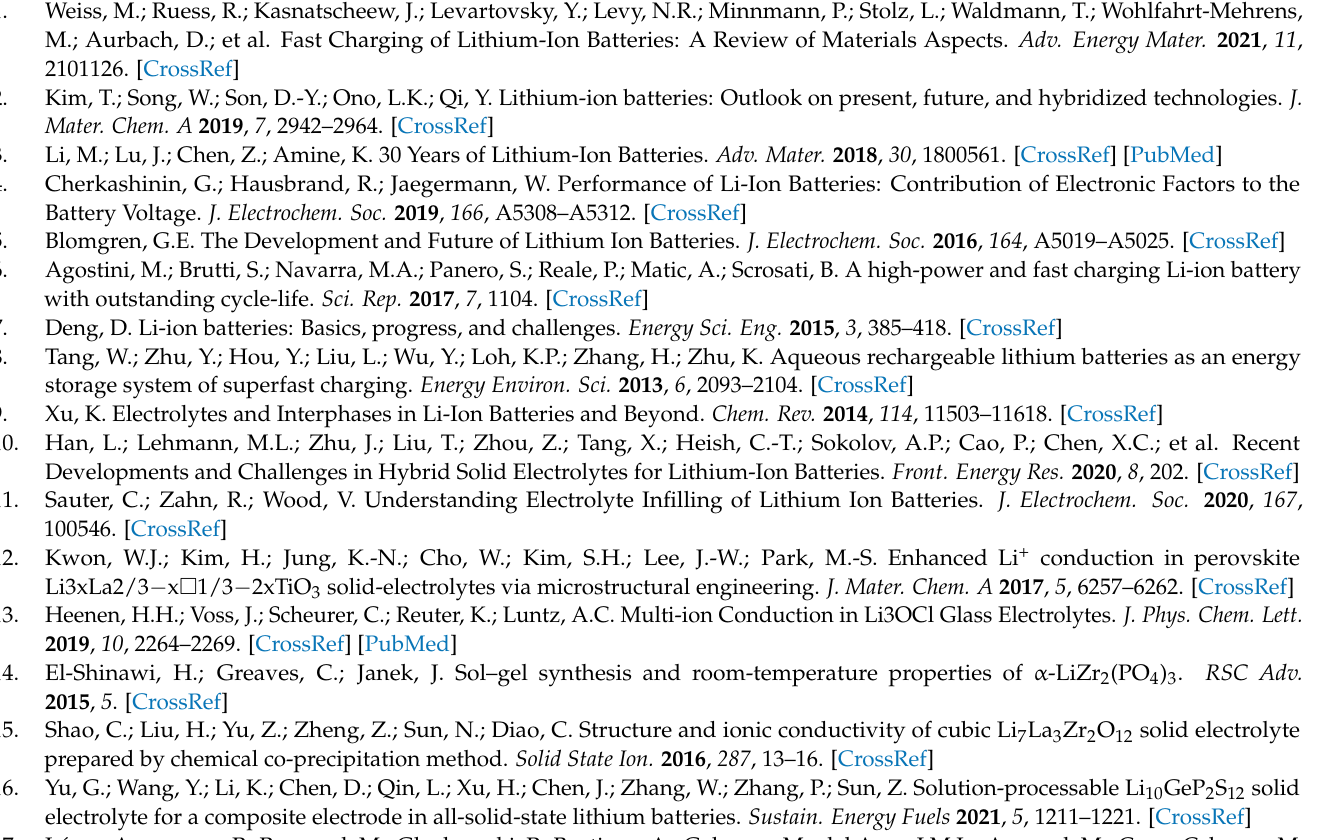
Figure S3: Different configurations of three Li atoms incorporated into Li 6 SiO 4 Cl 2